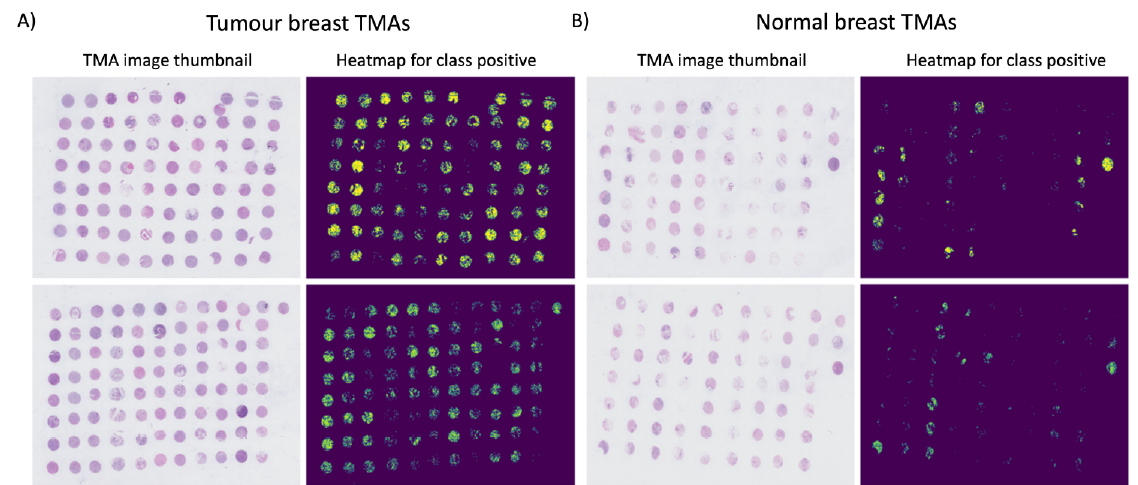
Figure 1. Probability heatmaps of tumour slides ( A ) and normal slides ( B ). The output probabilities for class positive predicted by the trained model on the TMA test set were used to reconstruct a heatmap of the full TMA slide. Each tile was represented as a 224 × 224 region within the image, which was then scaled to a thumbnail dimension. The heatmaps in ( A , B ) display only pixels with probabilities p > 0.5 for cancer